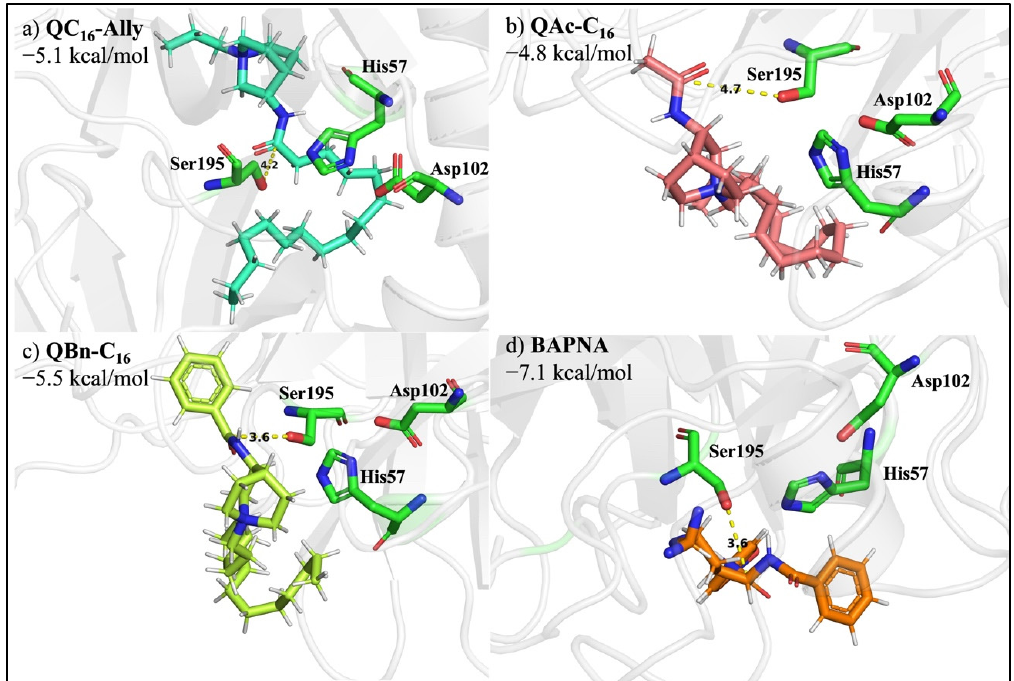
Figure 7. Docking analysis and binding affinities of QC16-Ally , ( a ) QAc-C16 ( b ), and QBn-C16 ( c ) in comparison with synthetic substrate BAPNA ( d ) as trypsin substrates. The snapshots illustrate the positioning of substrates within the enzyme active site with depicted catalytic amino acids, namely Ser195, Asp102, and His57.